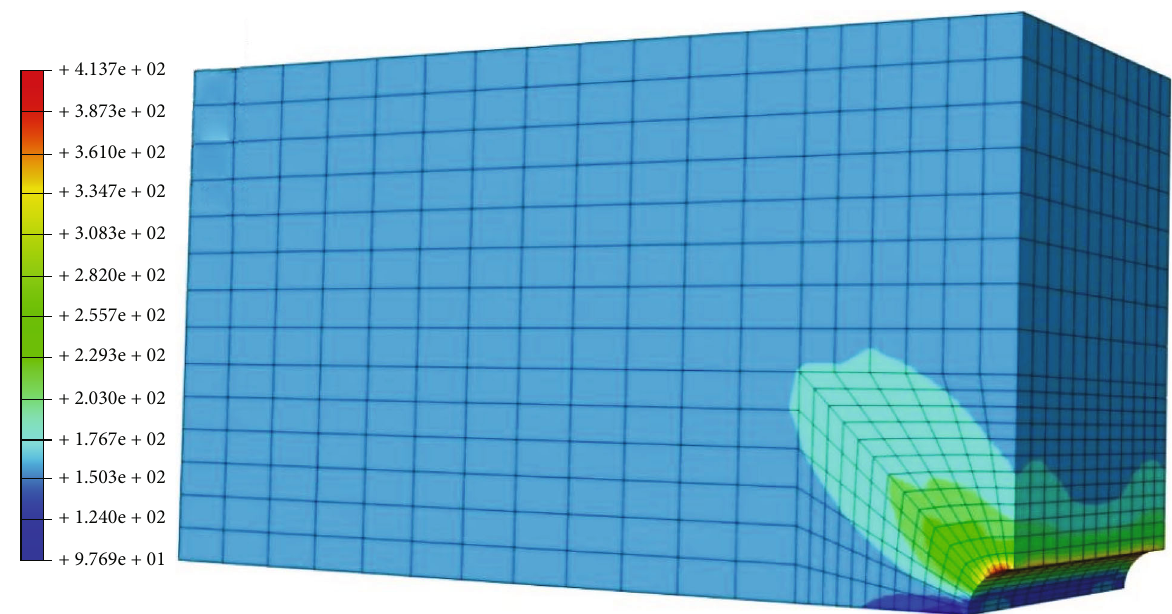
Figure 6: Maximum principal shear stress distribution of single-hole specimen (unit: